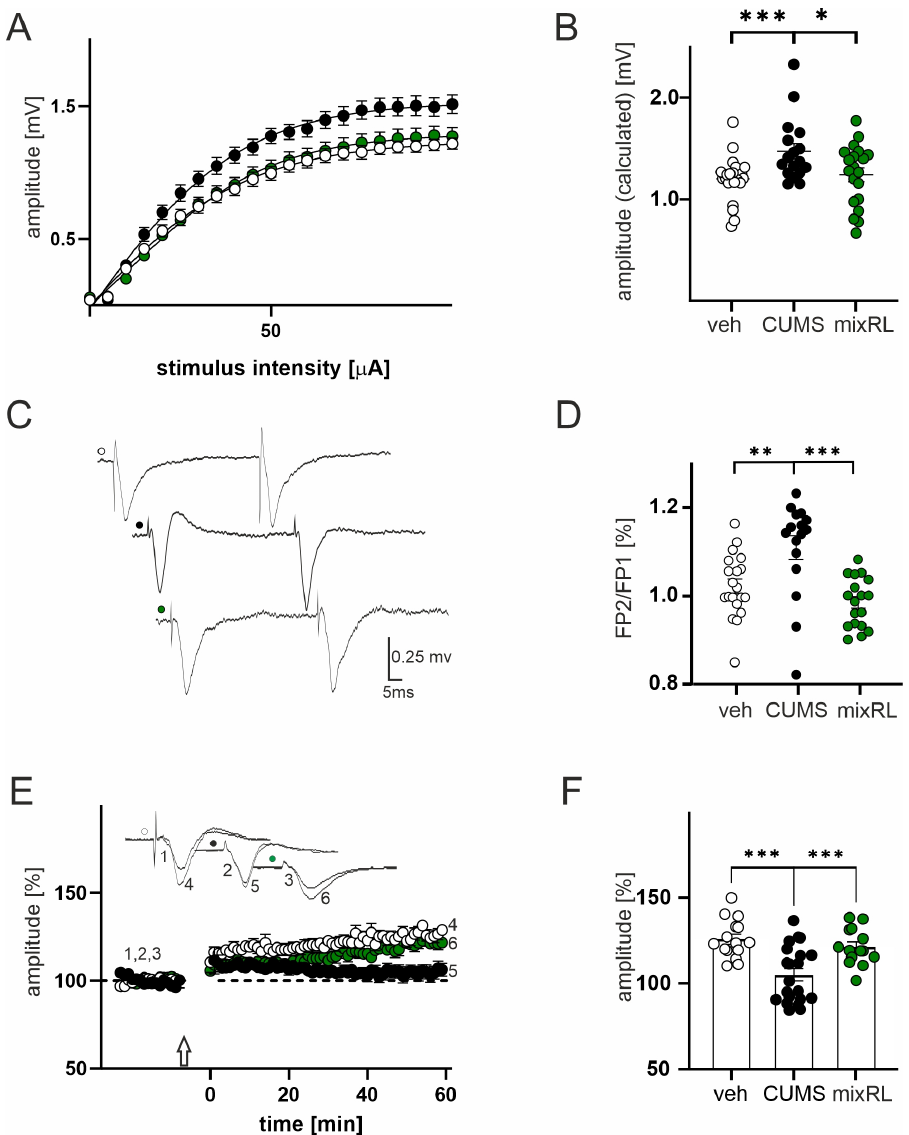
comparisons test, Figure 4A,B; black and white circles, respectively).